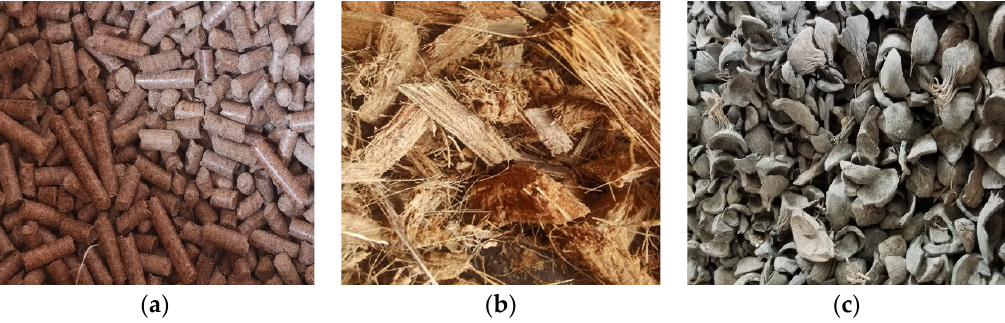
Figure 1. Biomass feedstocks used in the present study are ( a ) wood pellet, ( b ) coconut husk, and ( c ) palm kernel